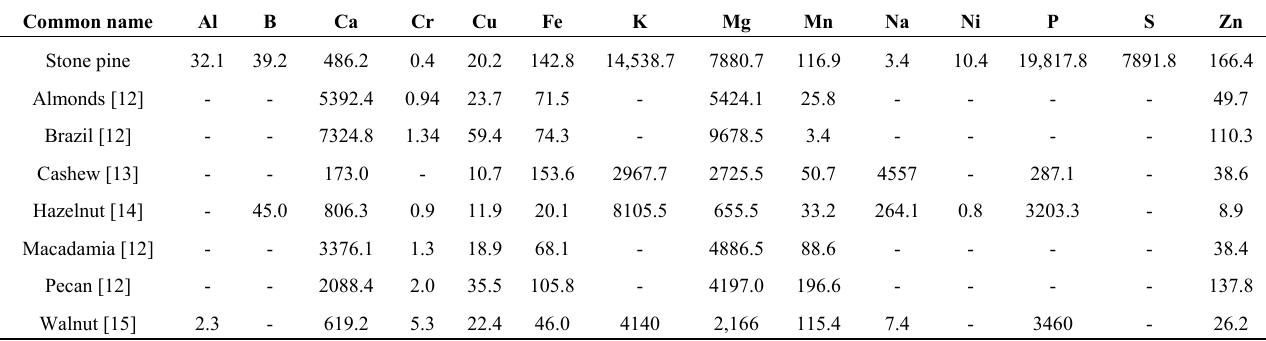
Table 3. Comparison of New Zealand Italian stone pine ( Pinus pinea ) mineral content (mg/kg) with published data for some common edible tree-nuts.